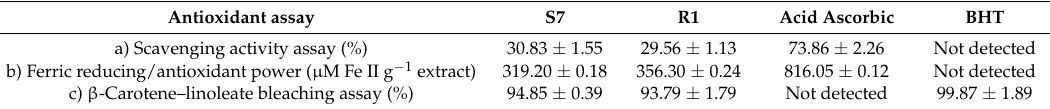
Table 8. Antioxidant activities of Malaysian cocoa shell extract